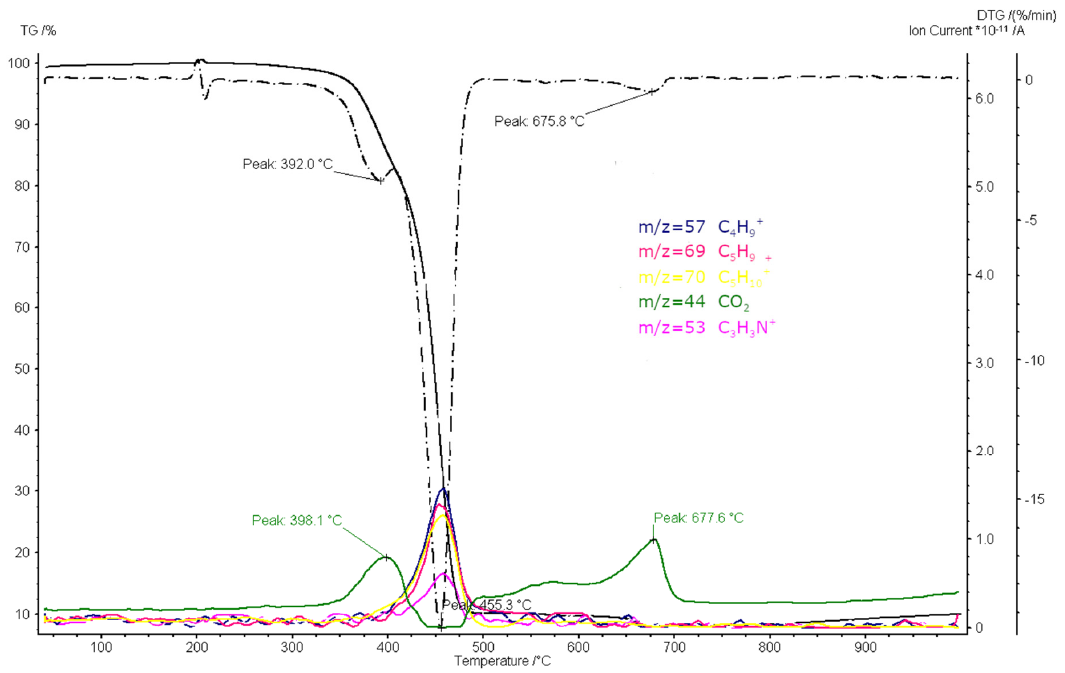
Figure 6. TG-DTG curves with curves of MS ion currents of volatile fraction ( m / z 18, 43, 55, 56).